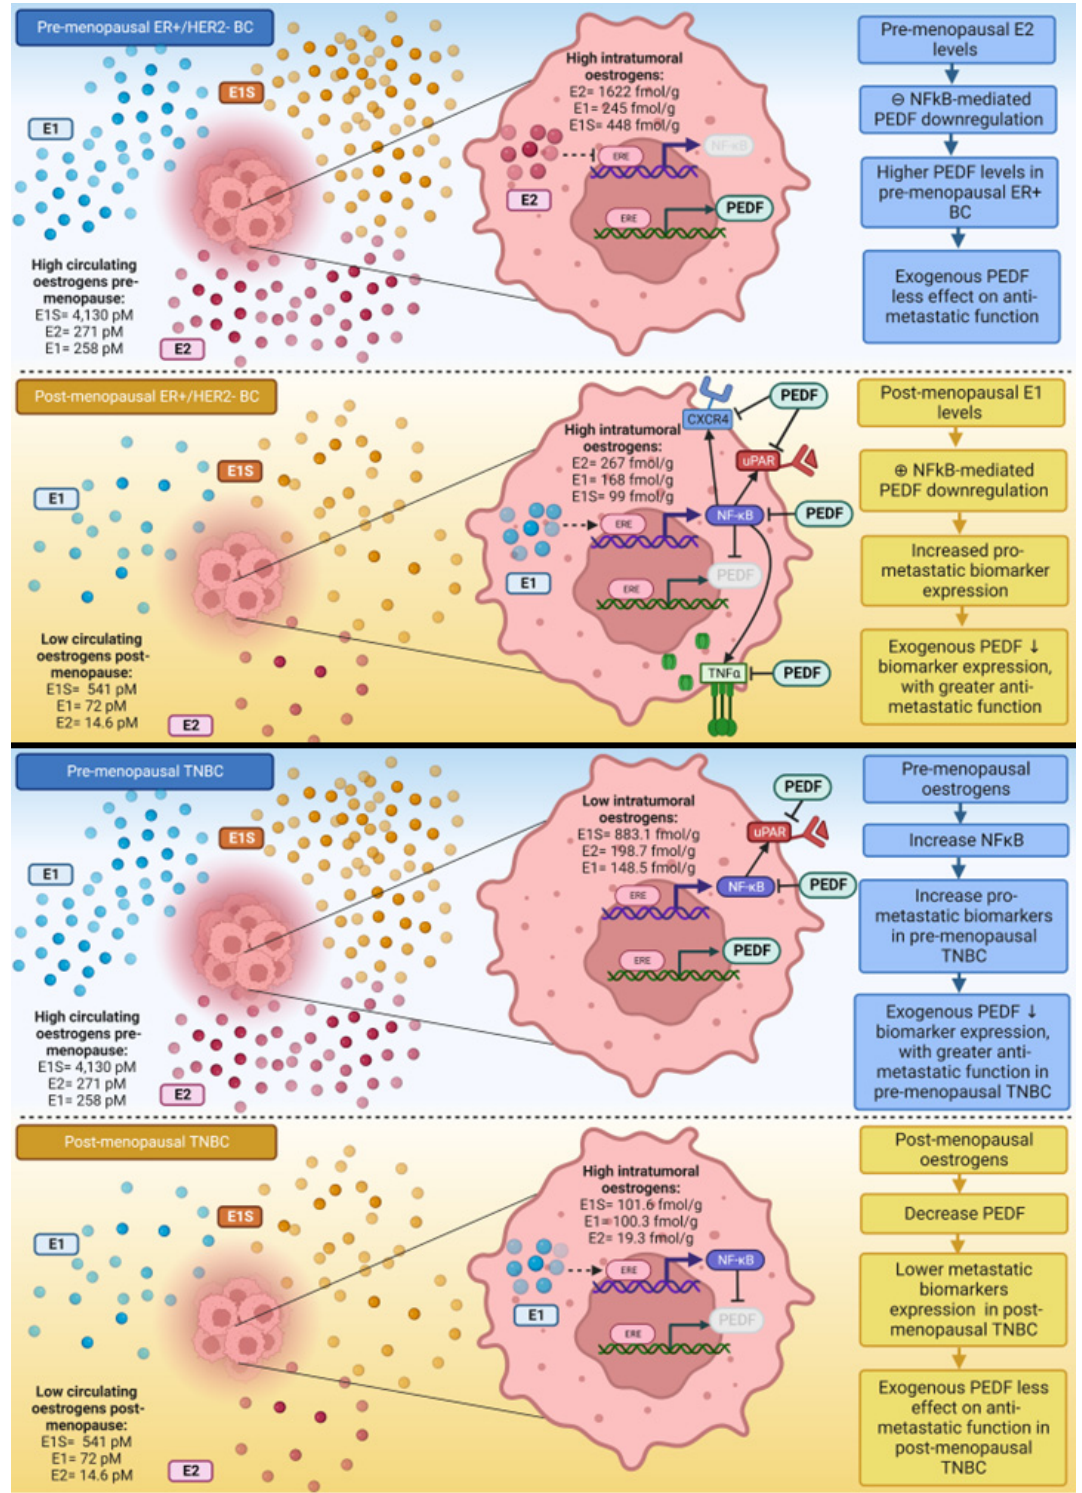
Figure 6. Summary of proposed mechanisms underlying differential PEDF expression and func- tion under pre- versus post-menopausal circulating oestrogen conditions in ER+/HER2- and TNBC cells. Circulating and intratumoral oestrogen levels in pre- and post-menopausal oestrogen receptor (ER)+ and ER- breast cancer patients as reported by Lønning et al. [35].